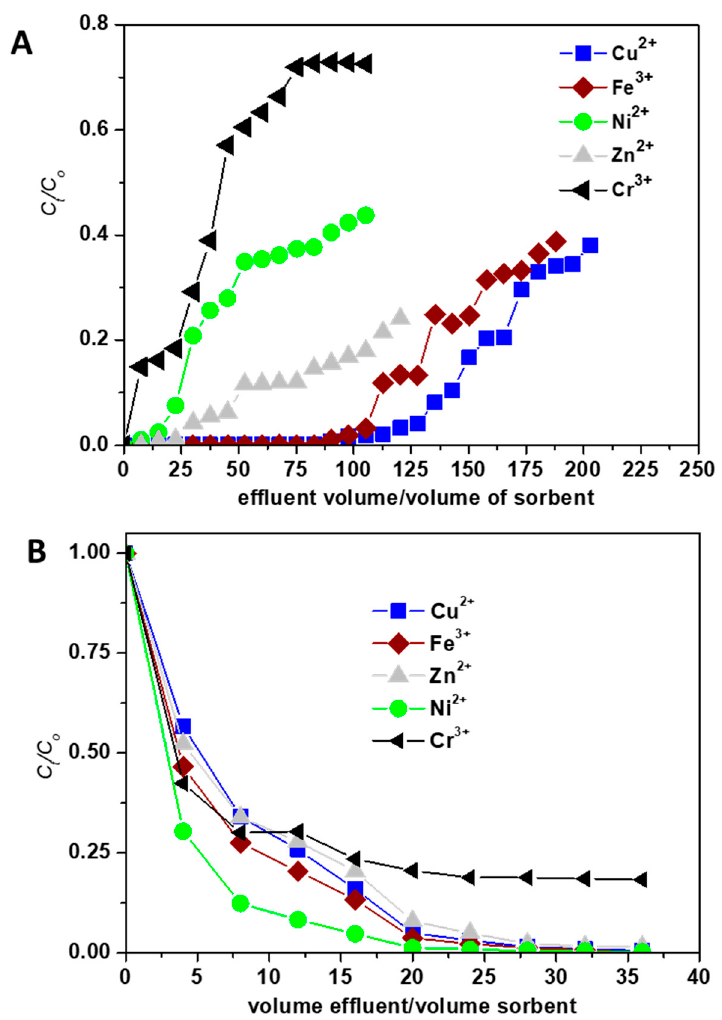
Figure 7. Sorption ( A ) and desorption ( B ) performance of CGCS_CPLH + composite sorbent in treating industrial wastewaters containing Cu 2+ , Zn 2+ , Ni 2+ , Fe 3+ , and Cr 3+ ions under fixed-bed column conditions.